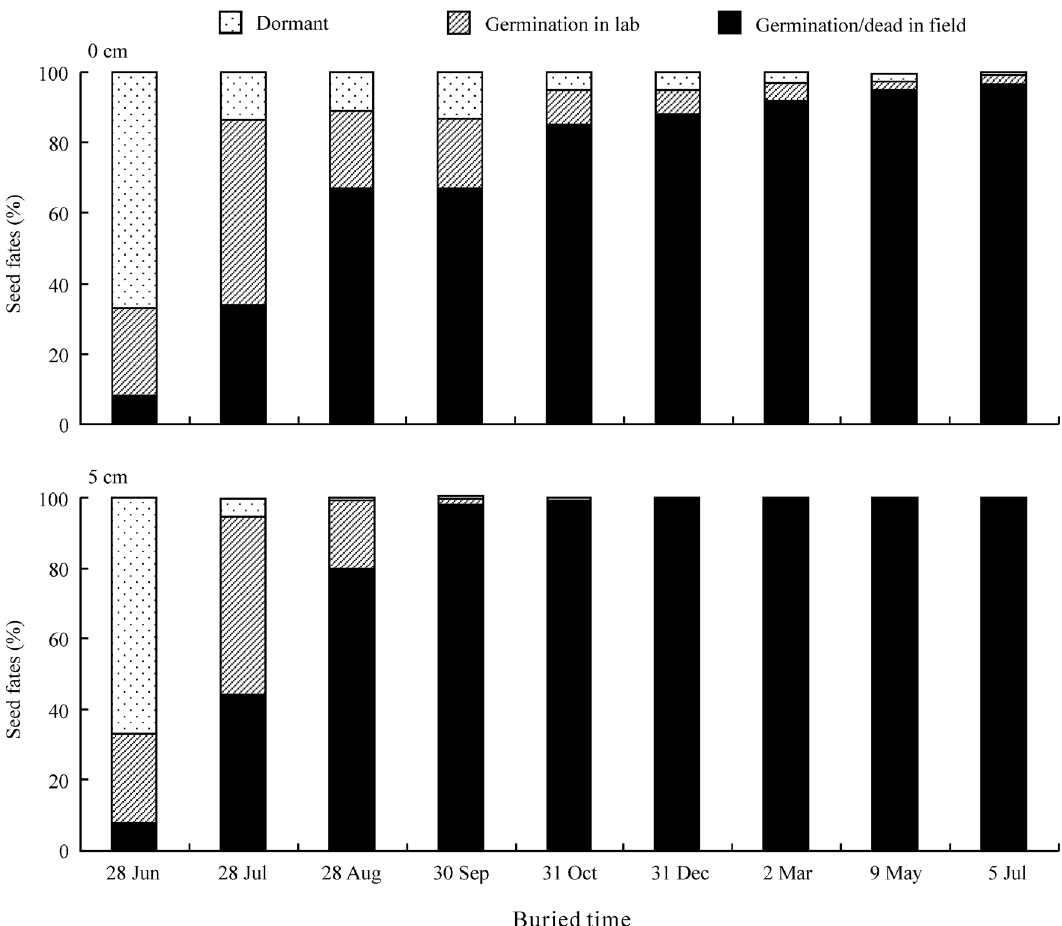
Figure 6. Fates of seeds in the field at 0 (surface) and 5 cm soil depths (n=6).